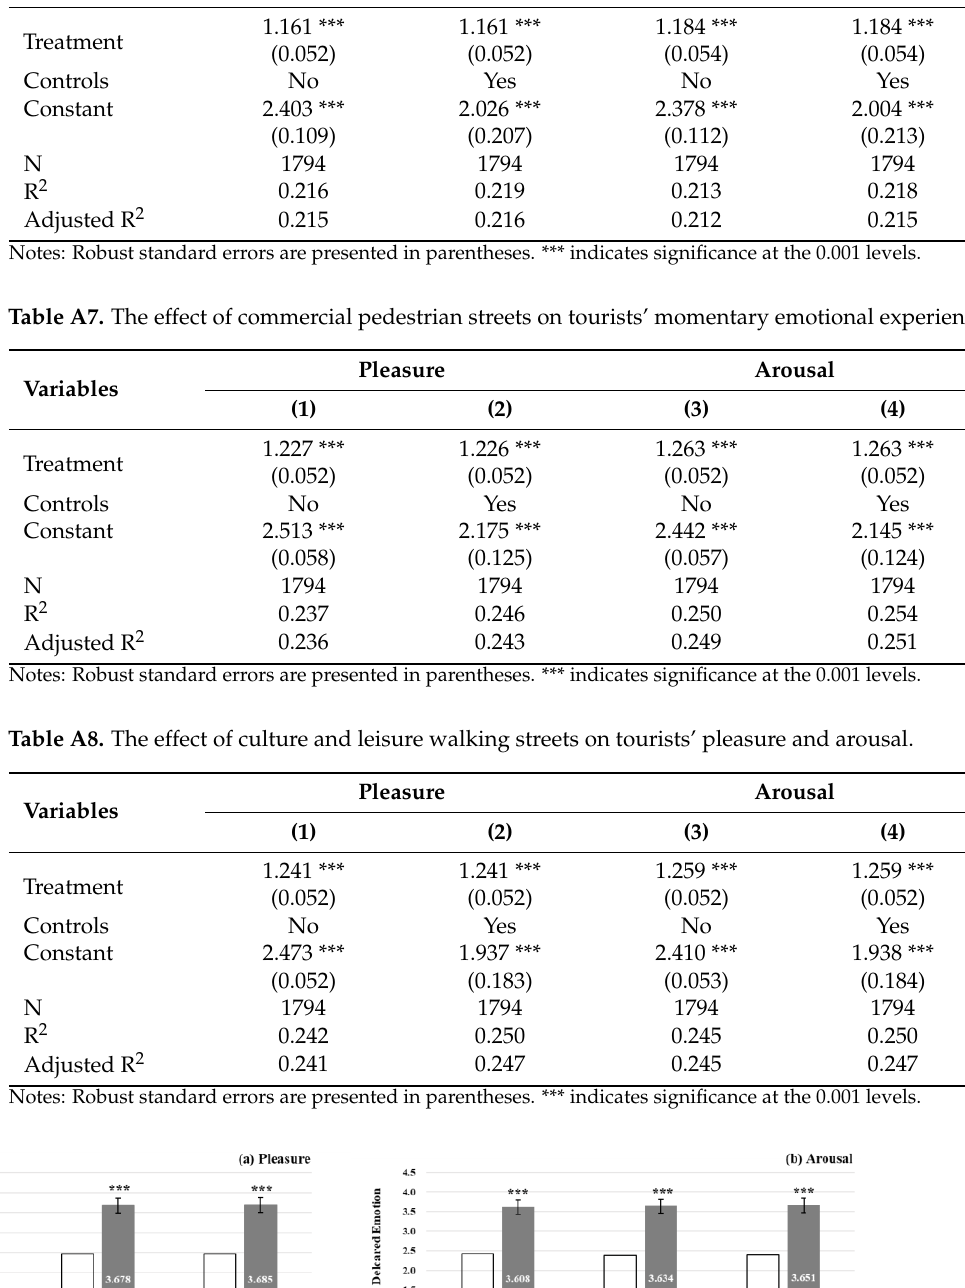
Figure A2. The impact of the three types of streets on tourists’ momentary emotional experience; ( a ) pleasure, ( b ) arousal. Note: Error bars represent 95% confidence interval. *** p  0.001. References 1.